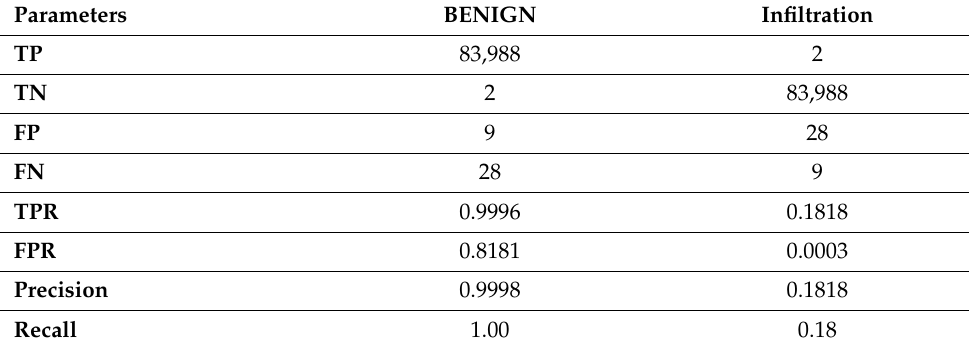
Table 7. Statistical report of Thursday afternoon test dataset.